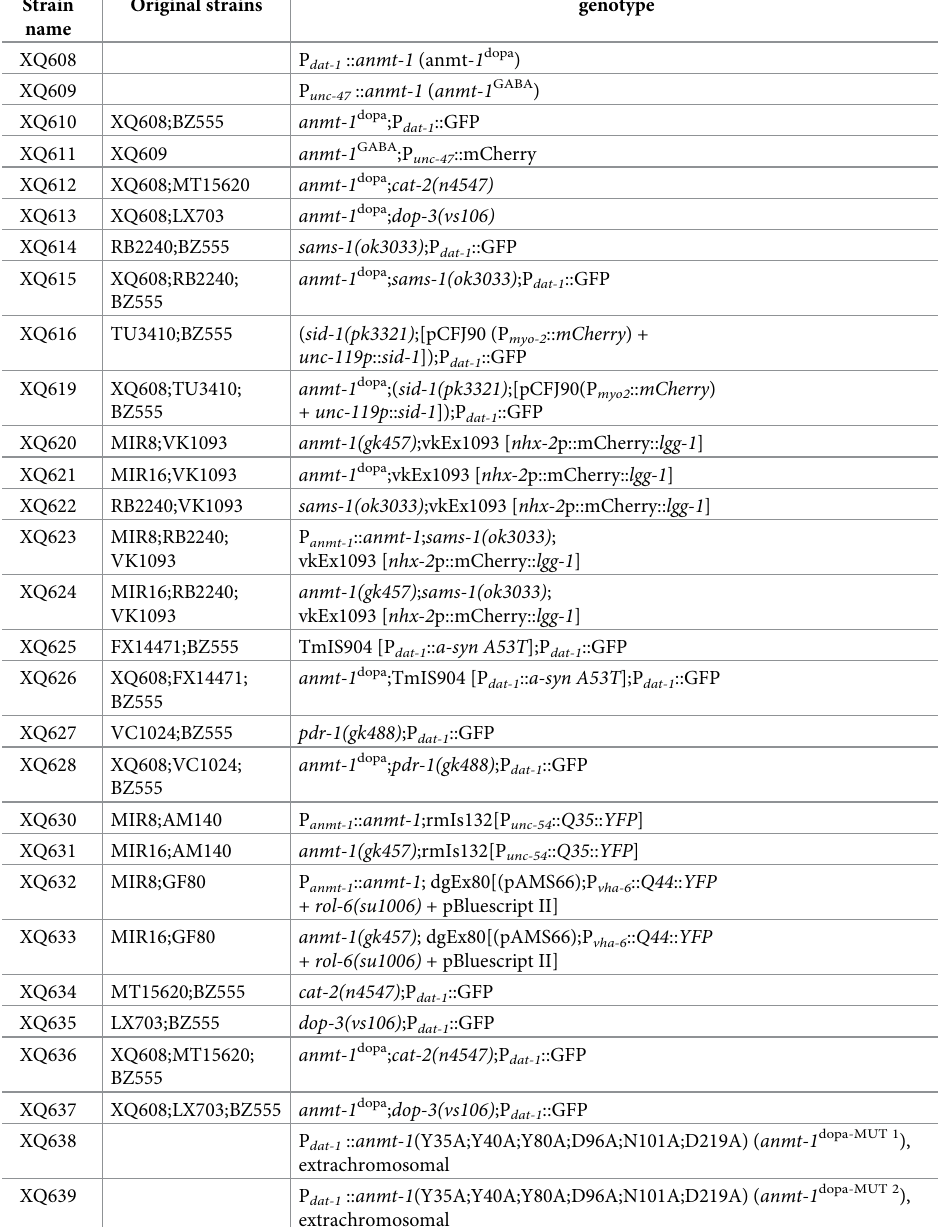
Table 2. Newly generated C . elegans